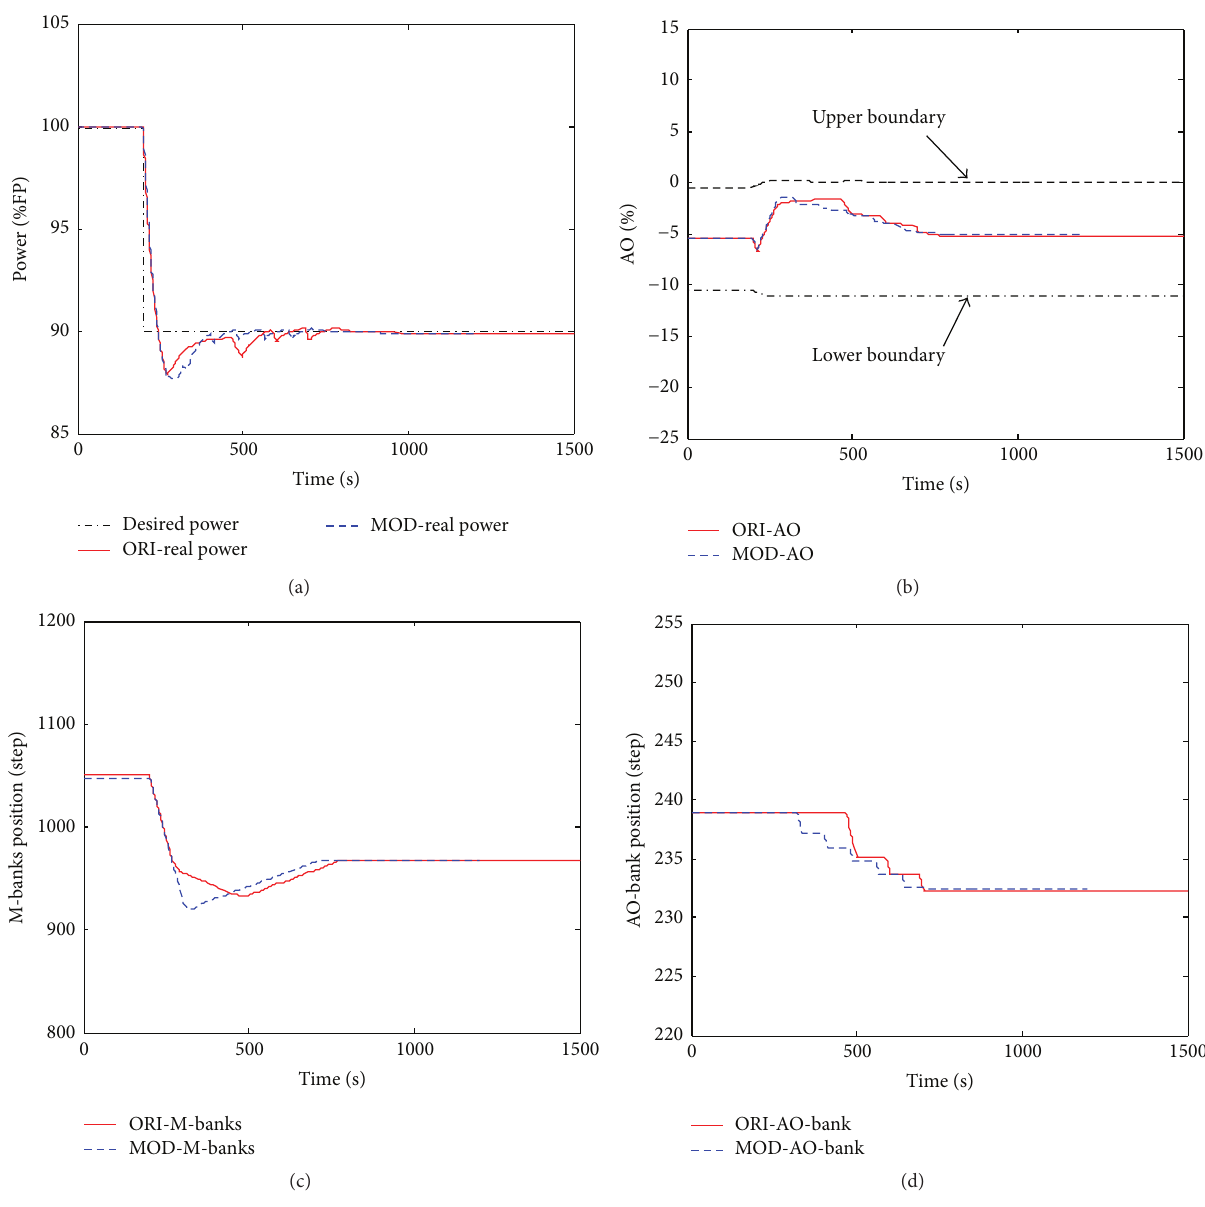
Figure 10: The 10% FP step load decrease simulation results obtained with the improved MSHIM control strategy: (a) desired and real nuclear powers (%FP), (b) AO (%), (c) M-bank position (Step), and (d) AO-bank position (Step).